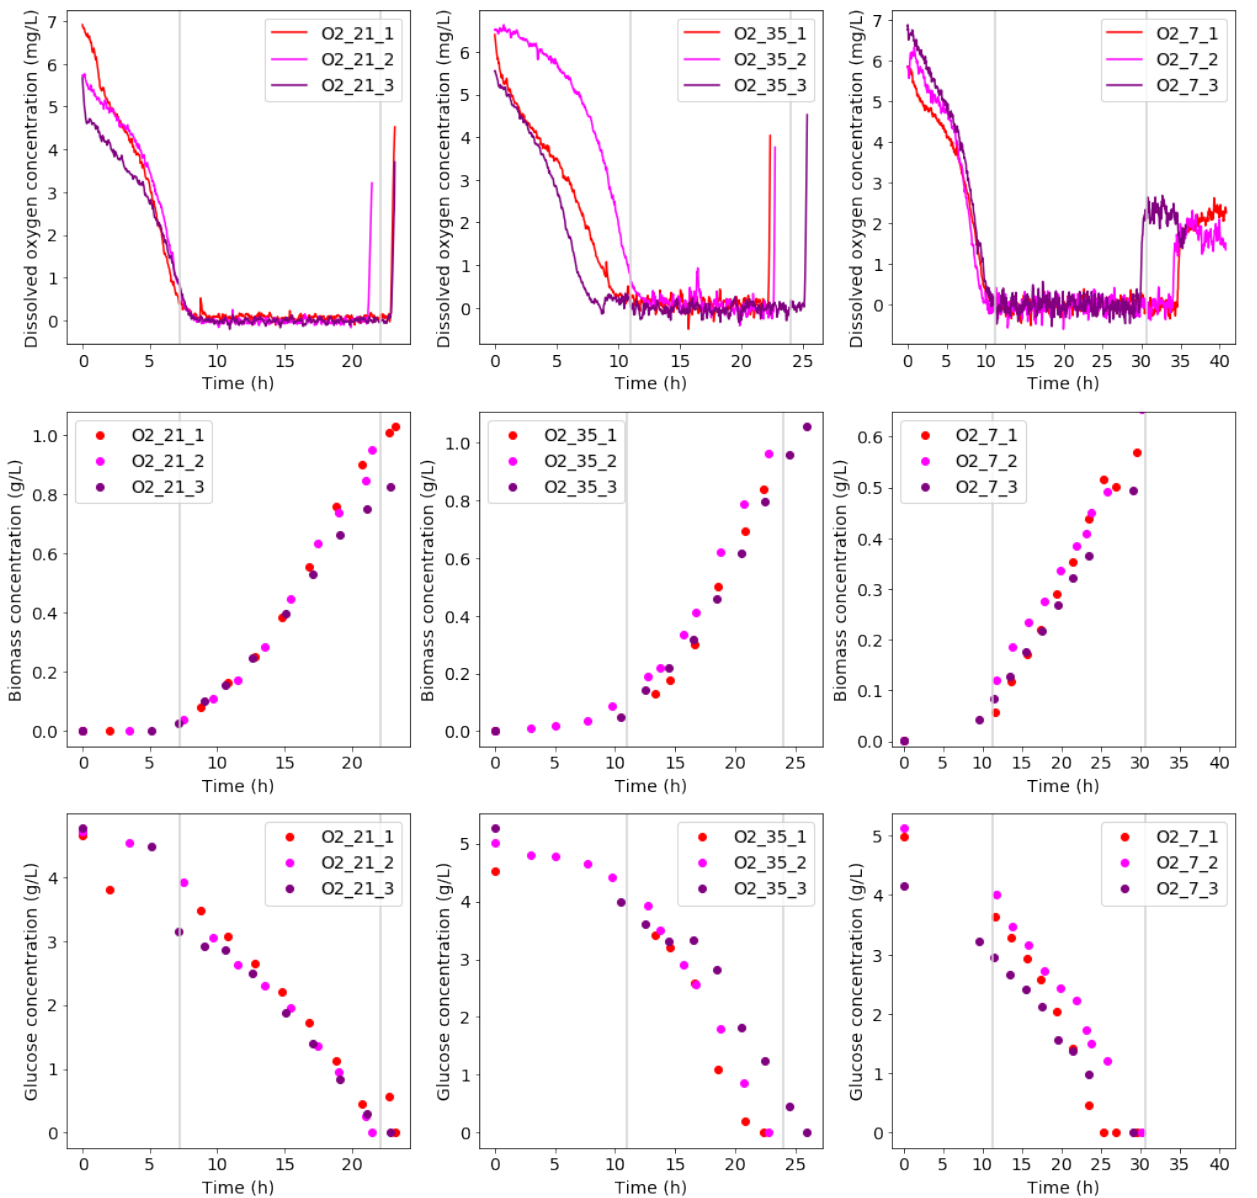
Figure 2. The concentration profiles for runs at various aeration feed conditions (O 2 _21, O 2 _35, and O 2 _7) are shown. The dissolved oxygen profiles for each condition are shown in the top row. The middle row shows biomass concentrations, whereas the bottom row shows glucose